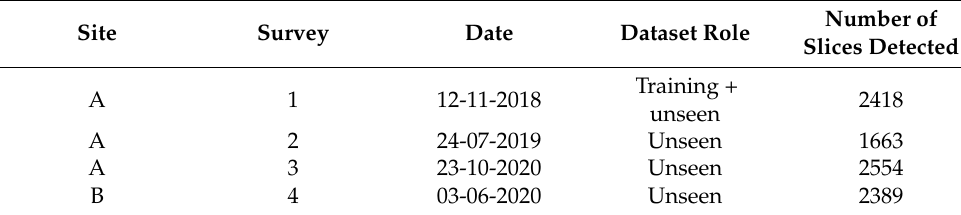
Table 1. The MBES datasets used in this paper.